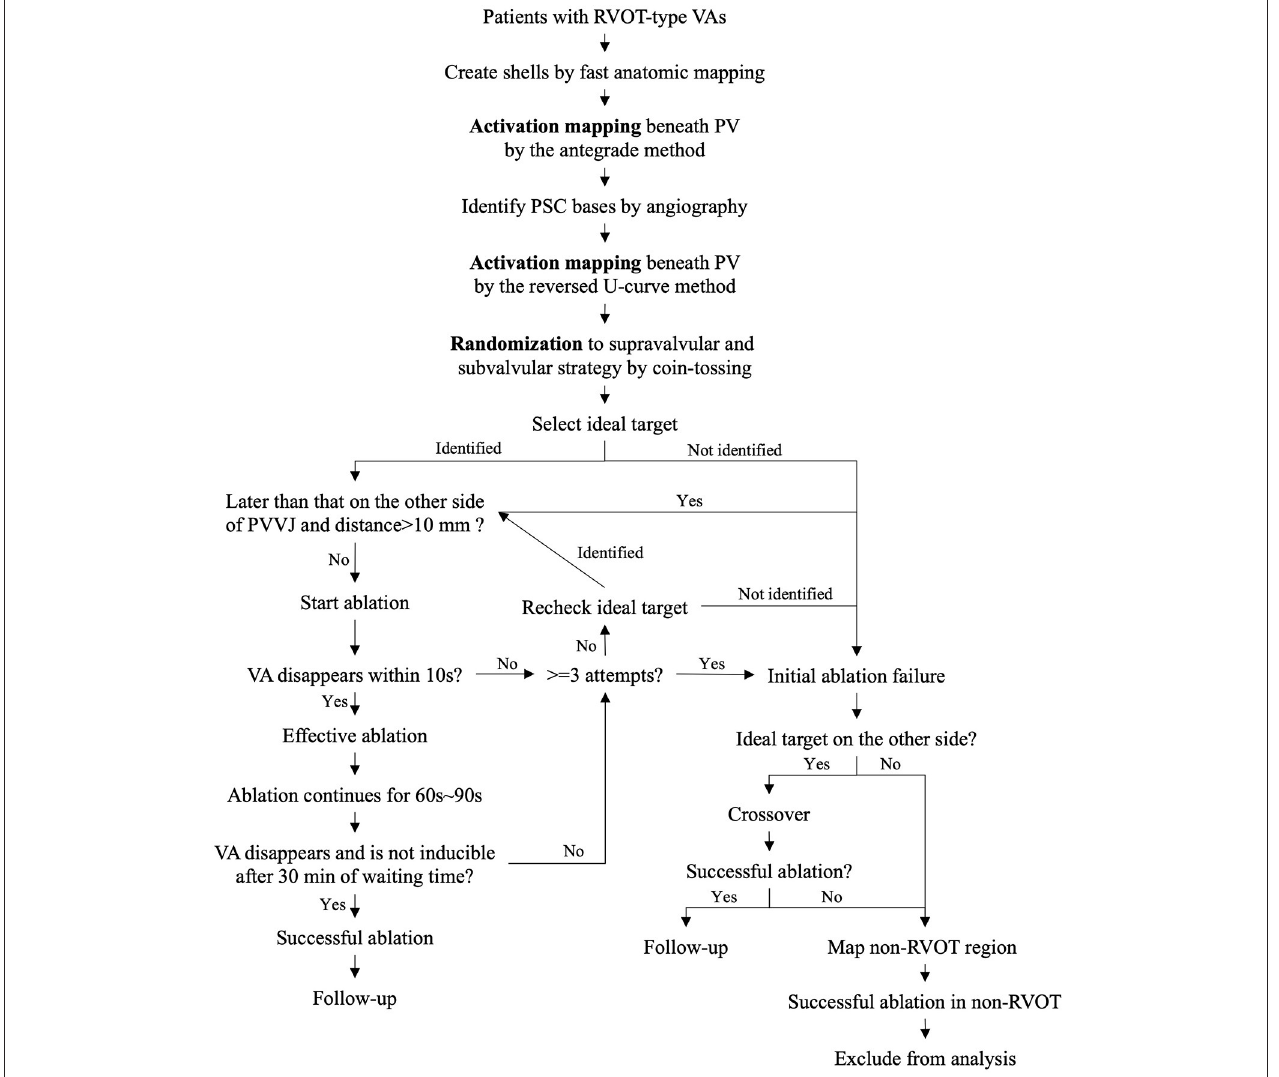
FIGURE 1 | Study design. PVVJ, pulmonary valve–ventricle junction; RVOT, right ventricular outflow tract; VA, ventricular